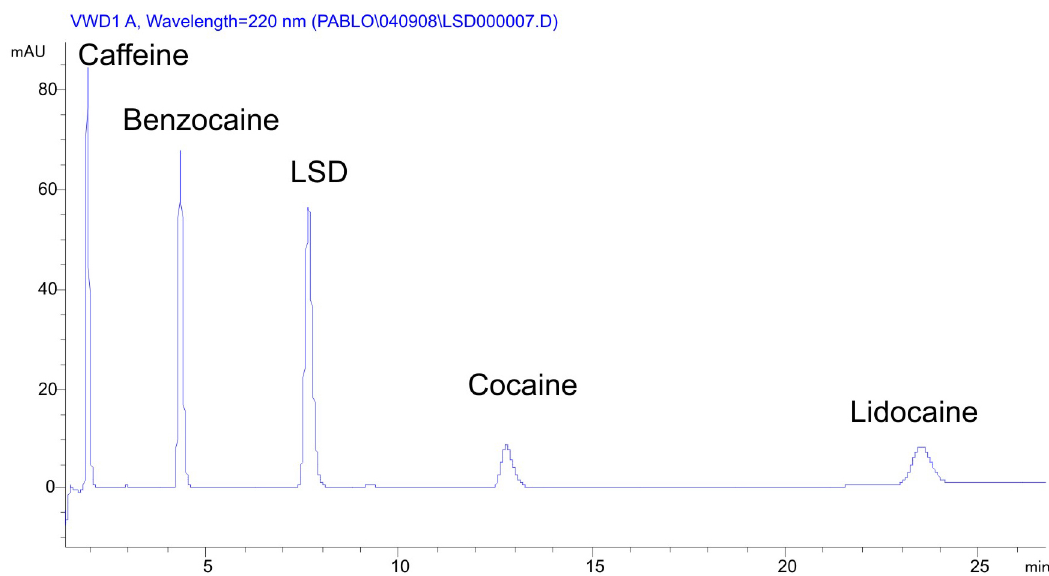
= 1.92 min), benzocaine (t r